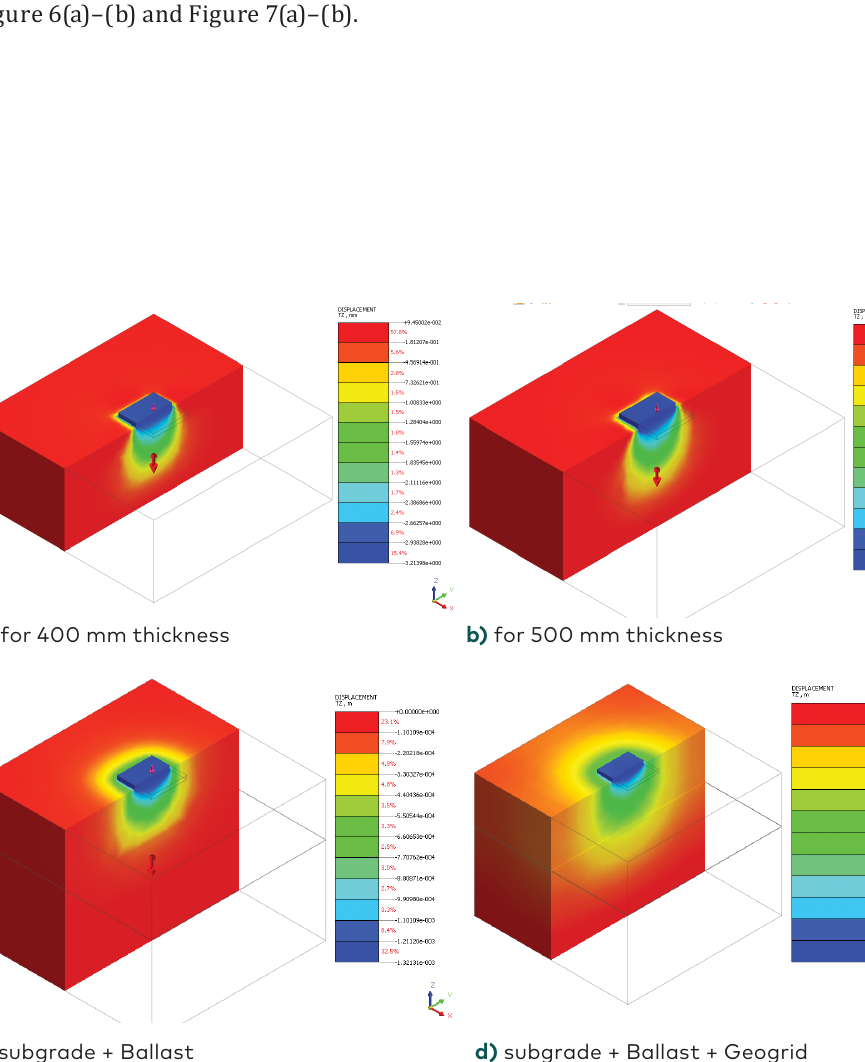
d) subgrade + Ballast +